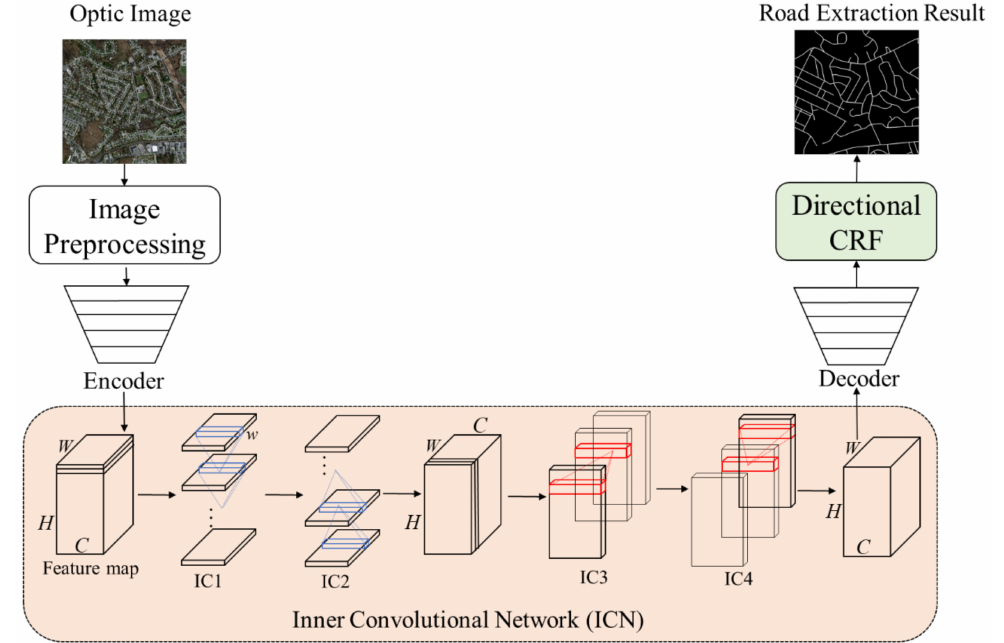
Figure 1. An overview of the proposed